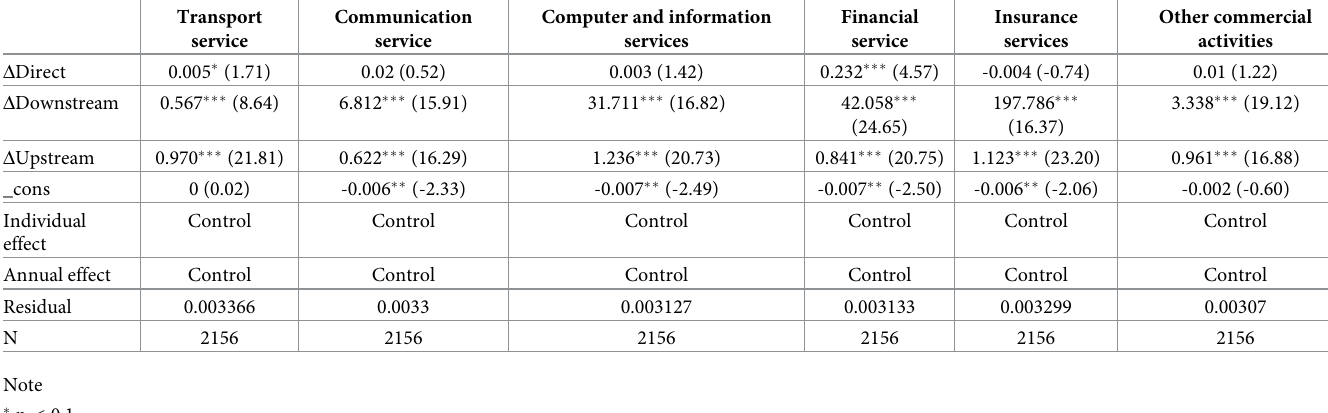
Table 3. Heterogeneity analysis results of producer service sub-sectors.